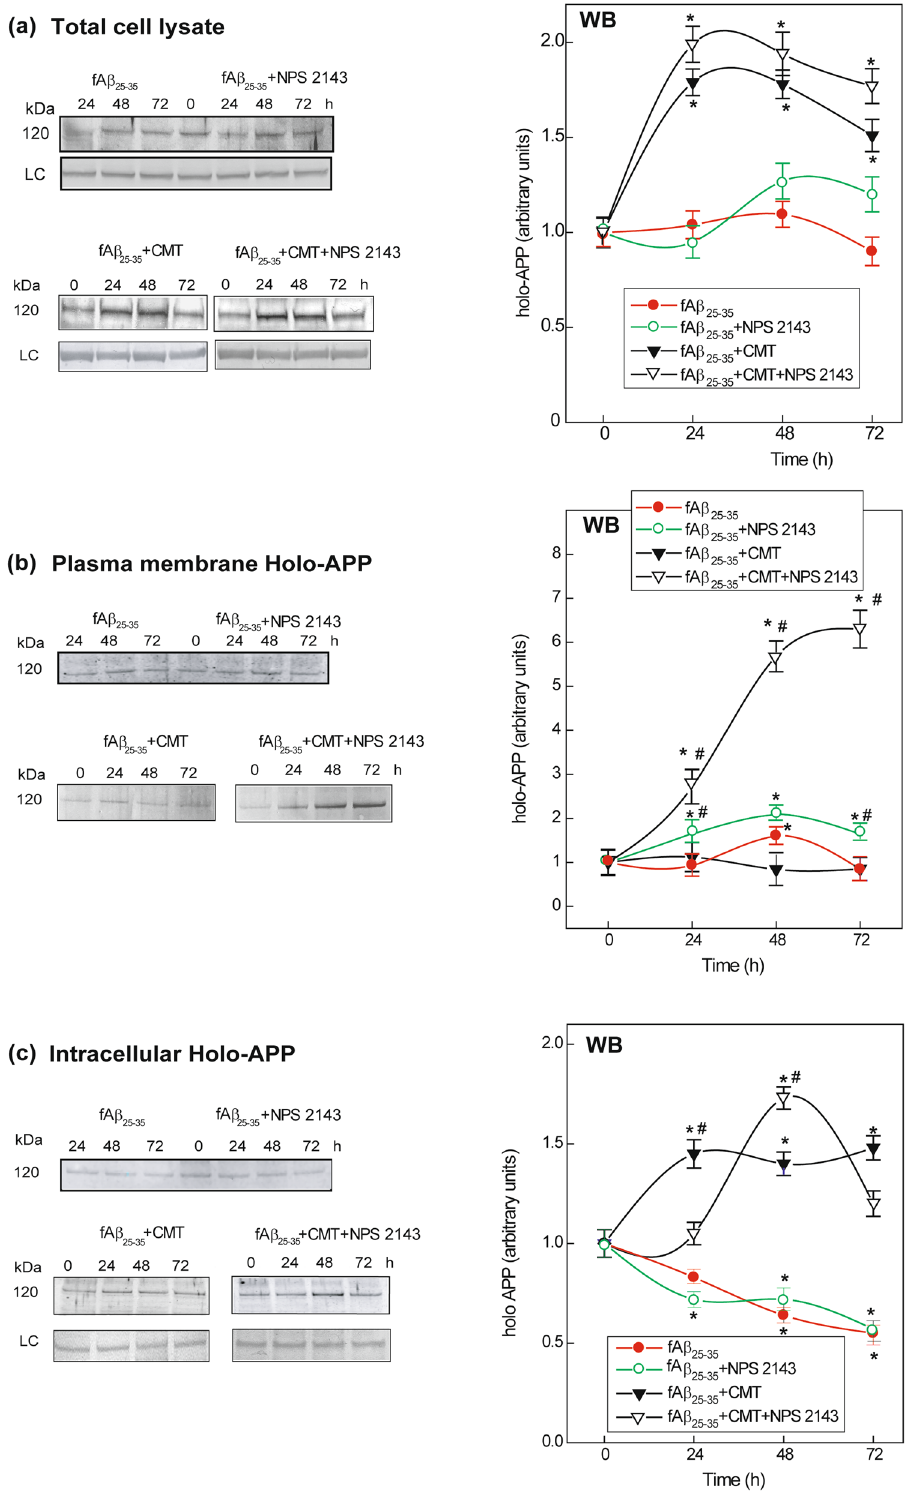
Figure 3. Holo-APP expression and distribution in human untreated and treated astrocytes. (a ) Left panel . Representative immunoblots showing the changes in holo-APP expression according to experimental treatments versus untreated controls in total astrocytes lysates. LC, loading control. In all cases blots have been cropped to size for clarity. Right panel . Densitometric evaluations of holo-APP bands for each treatment and time point. Points on the curves are means ± SEM of 3 independent experiments, with 0-h values normalized as 1.0. One-way ANOVA analysis of the complete data set: F = 8.889, P < 0.001; Bonferroni t-test comparisons of each treated group versus 0-h (controls): * P < 0.05. (b ) Left panel . Typical immunoblots showing alterations in plasma membrane hAPP levels (details in Methods ) according to experimental treatments versus